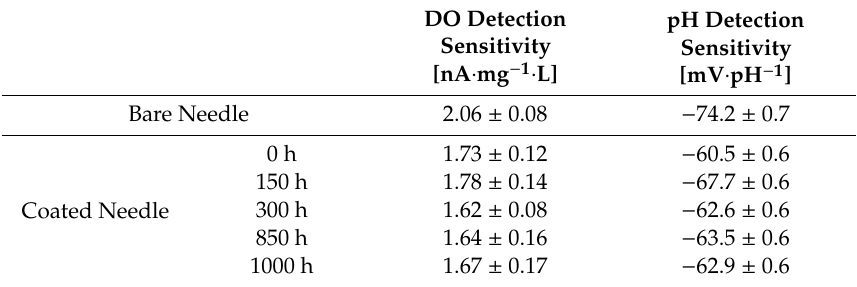
Table 2. DO and pH sensitivity of a Nafion ® coated needle over time in comparison with the uncoated bare ones. Times correspond to hours from the calibration of the bare needle just before modifying the sensor with the Nafion ®